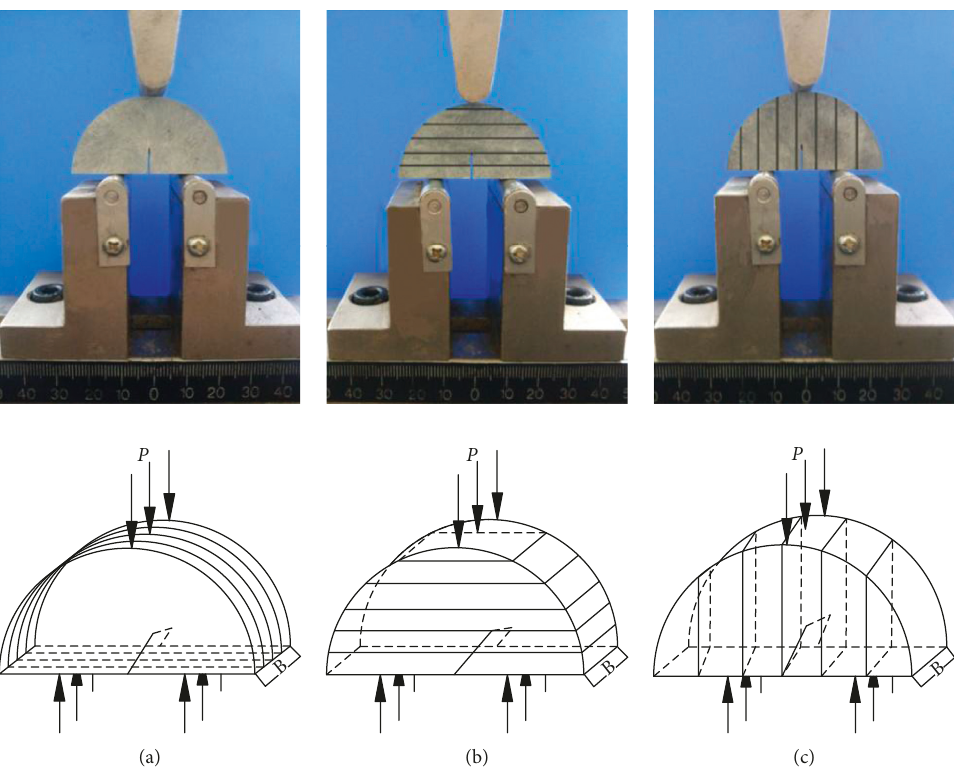
Figure 3: Three types of SCB specimens. (a) Type A (divider). (b) Type B (arrester). (c) Type C (transverse).